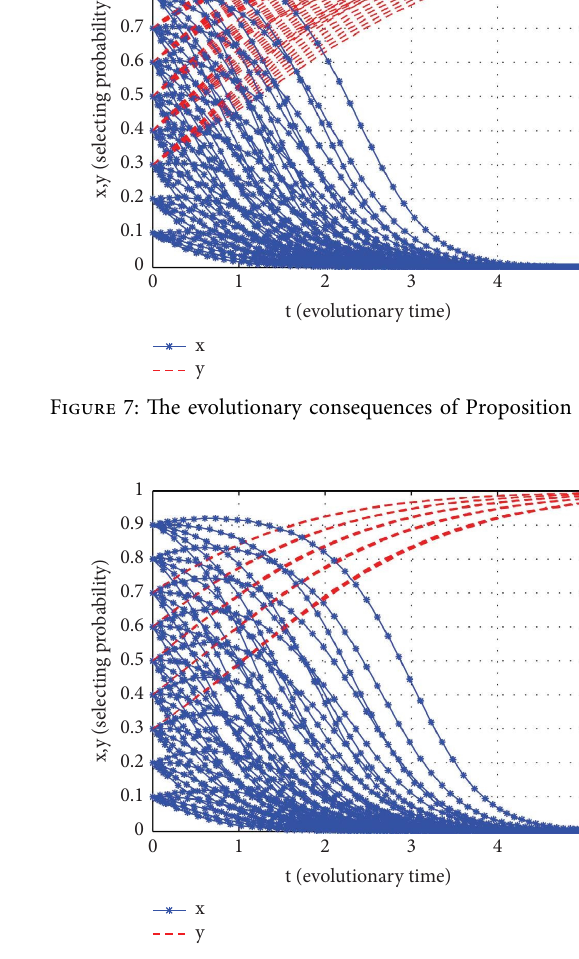
Figure 8: Te evolutionary consequences of Proposition 4